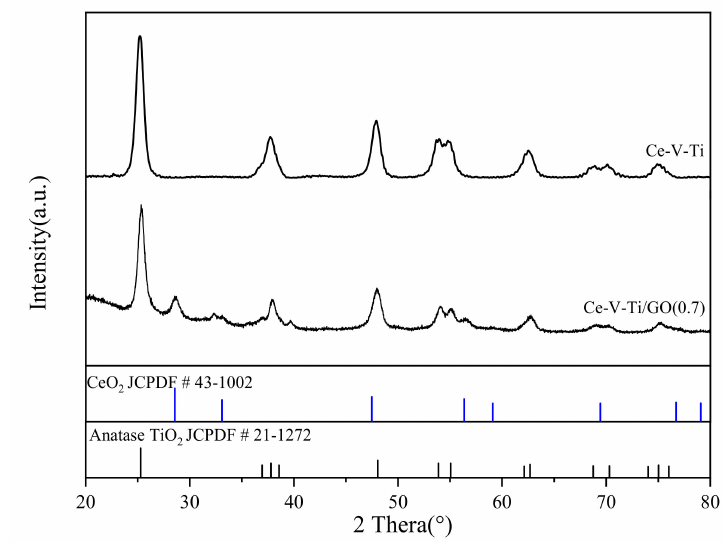
Figure 5. X-ray di ff ractometer (XRD) patterns of the Ce-V-Ti and Ce-V-Ti / GO